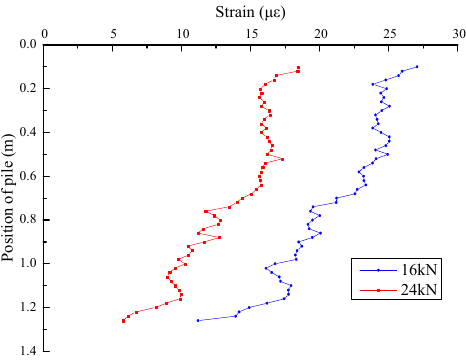
Figure 8. Average strain curves of model pile.